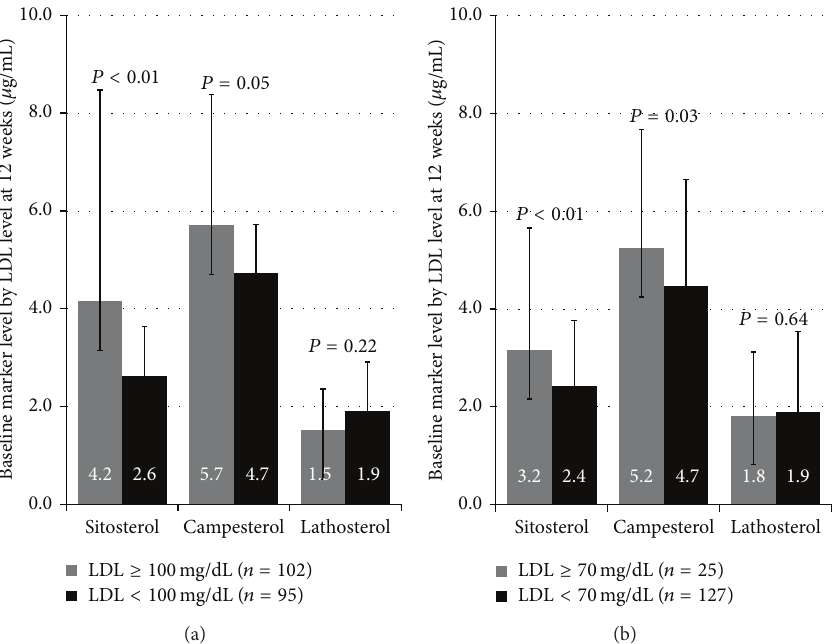
Figure 4: (a) The baseline levels of cholesterol synthesis and absorption markers according to the LDL-C levels at 12 weeks irrespective of treatment methods. The baseline levels of sitosterol and campesterol are significantly higher in patients whose LDL-C levels at 12 weeks are greater than or equal to 100mg/dL than in patients whose LDL-C levels at 12 weeks are less than 100mg/dL. In terms of the baseline level of lathosterol, there is no significant difference. (b) The results are the same when the cut-off of LDL-C is defined as less than 70 mg/dL at 12